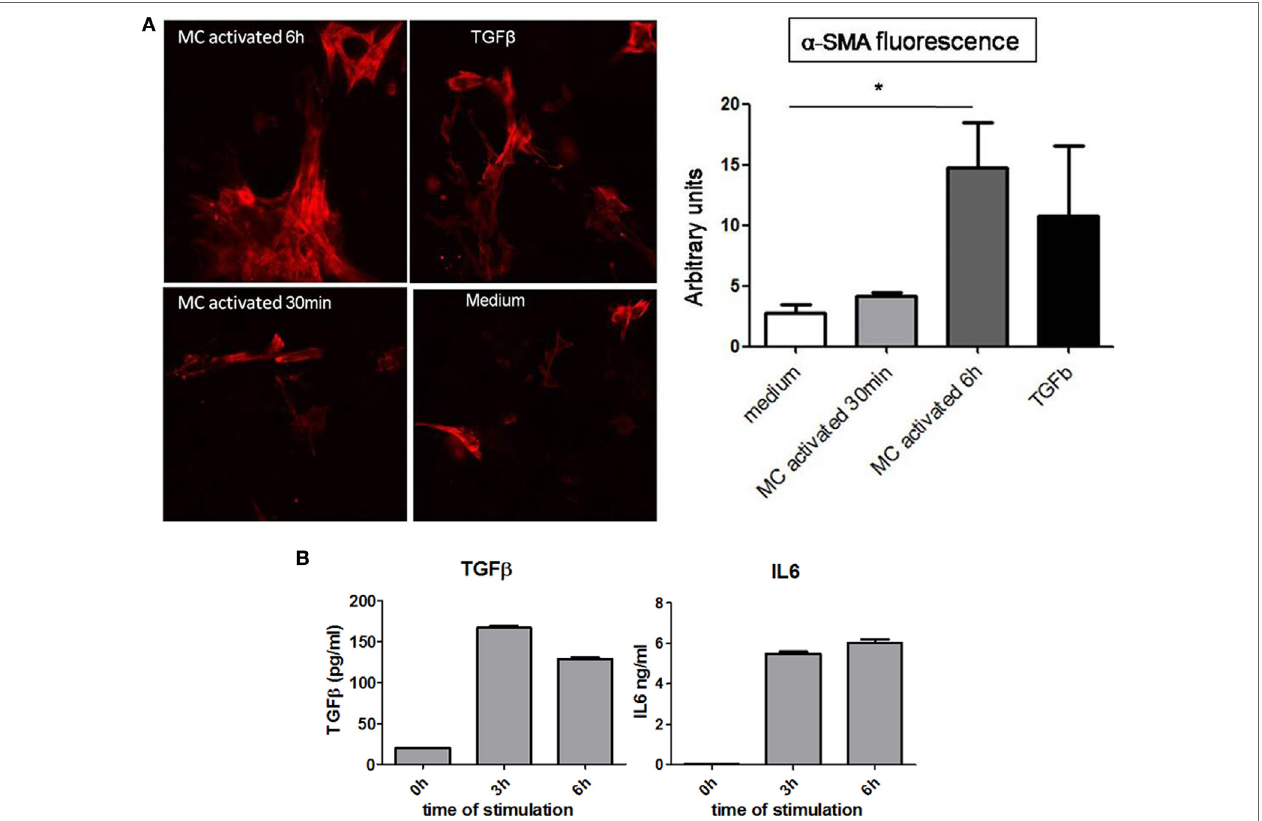
FigUre 7 | analysis of role of mast cell (Mc) in inducing eMT in proximal kidney tubular cells . (a) Representative images of α -SMA immunofluorescence and relative quantification using ImageJ software in kidney proximal tubular cells after (time of) incubation with medium alone, TGF β (50 ng/ml) and supernatants from activated MC (30 min and 6 h) through the IgE receptor. Data are the mean ± SEM, * p ≤ 0.05. (B) IgE anti-DNP sensitized bone marrow derived MCs were washed and stimulated with 30 ng/ml of DNP-HAS. Supernatants were collected at indicated time points and cytokine concentrations were determined by ELISA subtracting the values in medium alone. Data are mean ± SD of triplicate